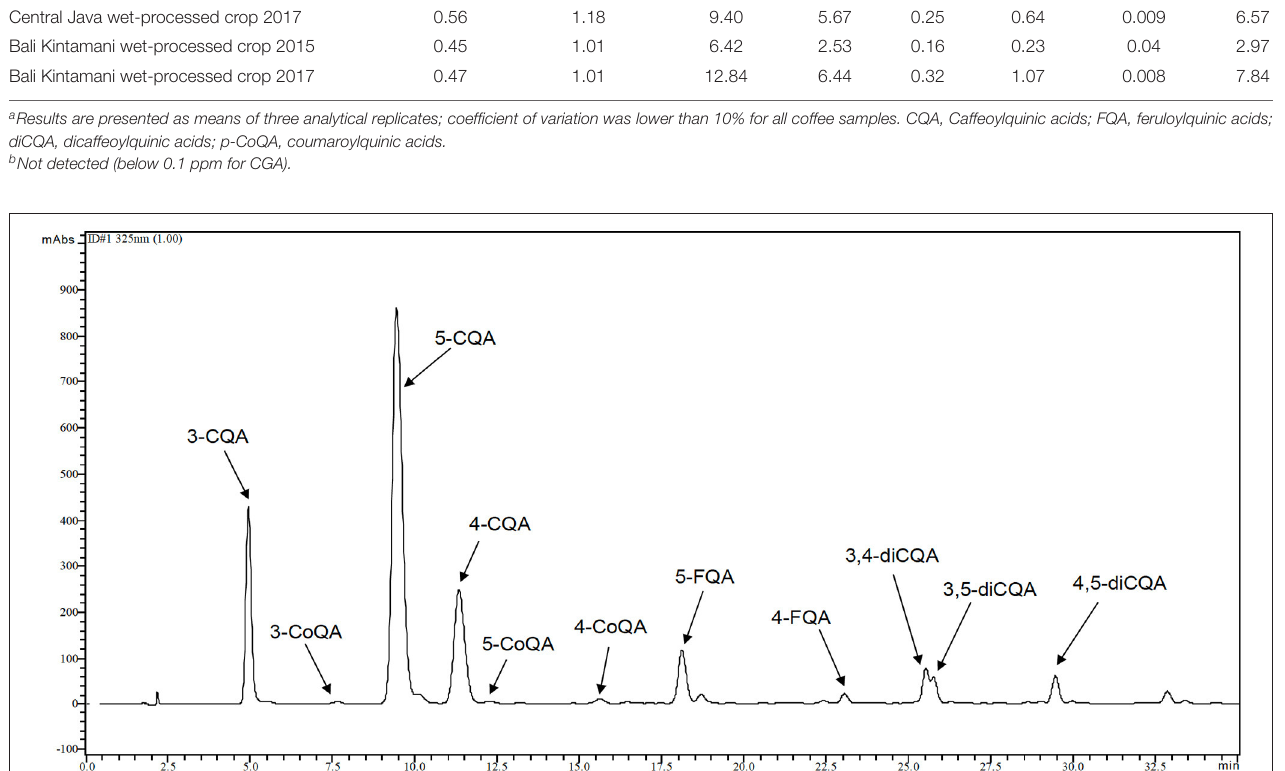
samples: 3-CQA, 4-CQA, 5-CQA, 3-CoQA, 4-CoQA, 5-CoQA, 4-FQA, 5-FQA, 3,4-diCQA, 3,5-diCQA and